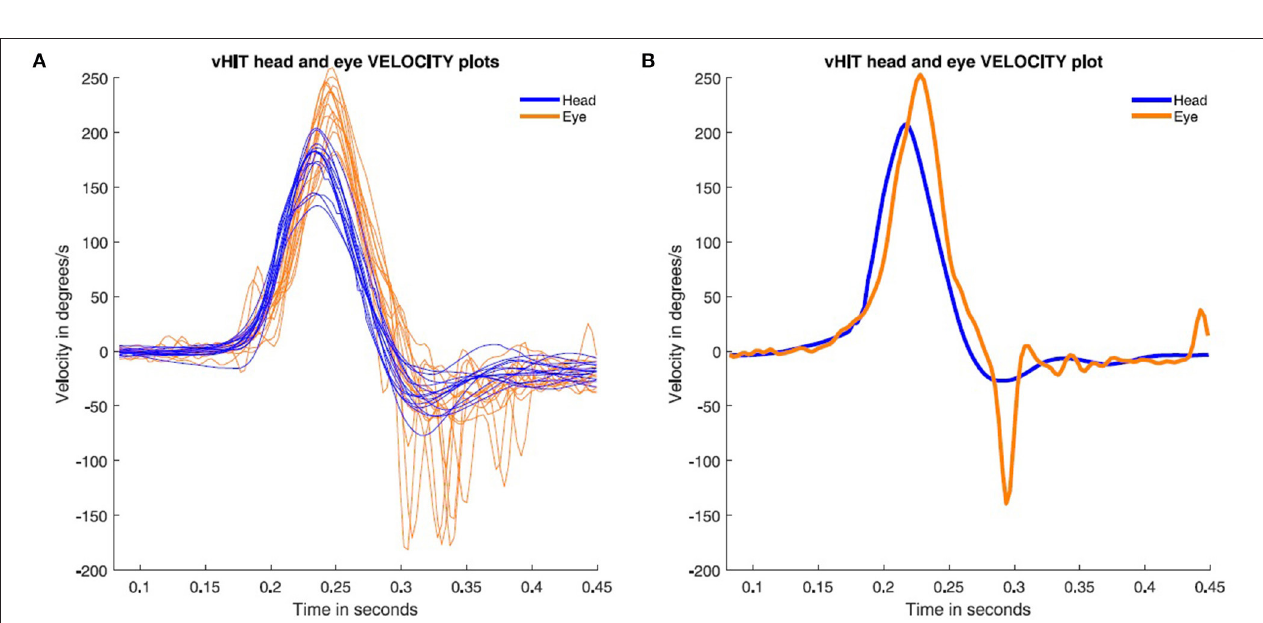
FIGURE 1 | Right and left pure tone air-conduction audiograms from the last 3 years. Unilateral right fluctuating low and mid-frequencies hearing loss with a PTA 40 dB-HL is present at testing in 2019, 2020, and 2021 while normal hearing was obtained in left ear on these occasions with a PTA of 20 dB-HL. Hearing loss levels and PTA calculation methods according to BIAP 2017 (www.biap.org).